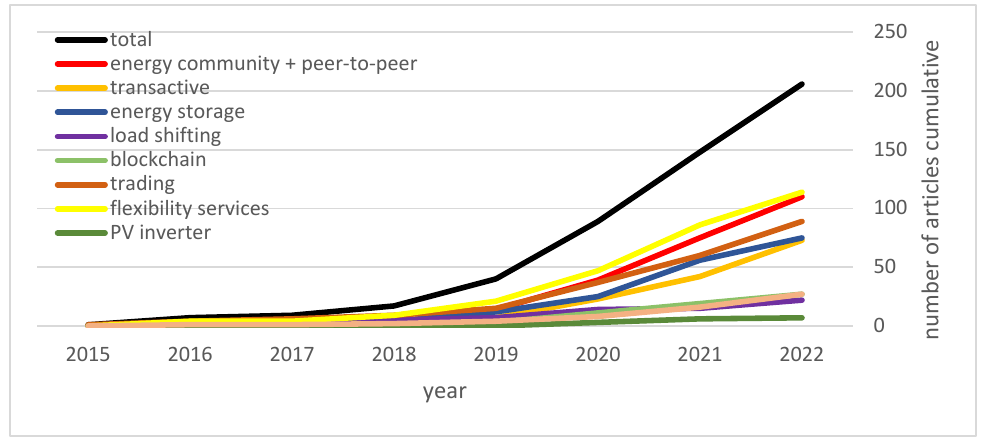
Figure 3. The number of articles published in a given year cumulatively from 2015 for each keyword corresponding to the research directions on the topic of grid flexibility.